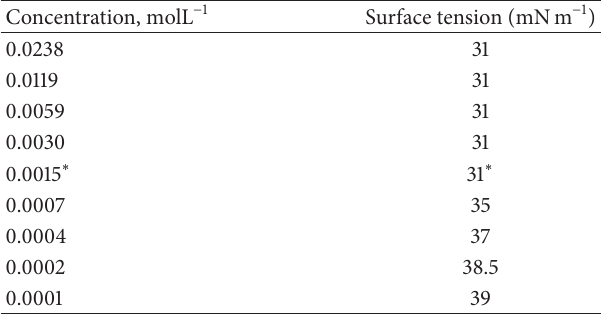
Table 1: Surface tension (mNm − 1 ) values of prepared